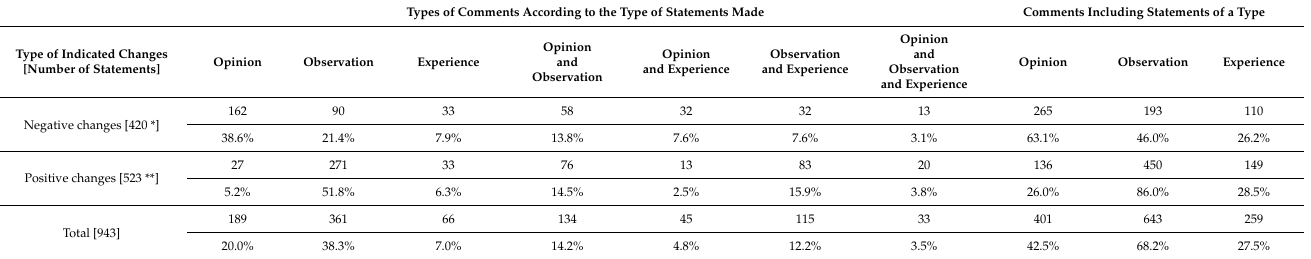
Table 3. The structure of the results of coding the respondents’ statements about changes in the studied